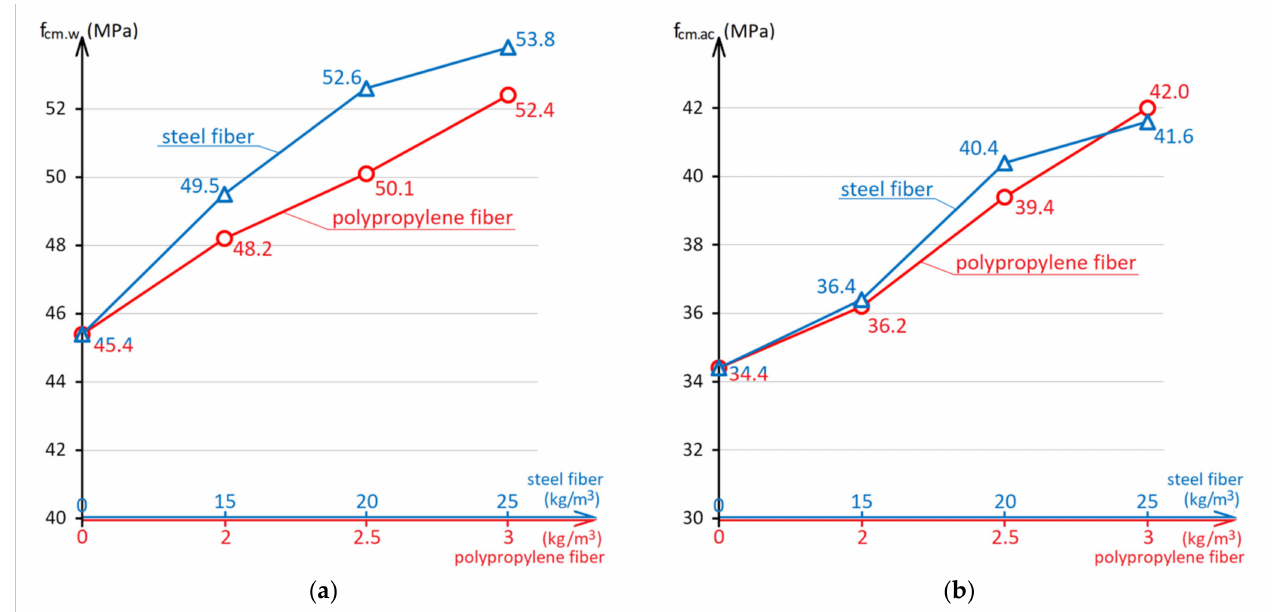
Figure 12. The influence of the steel and polypropylene fibers amount on the concrete strength after 6 months exposure to water ( a ) and in an acidic environment with pH = 3 ( b